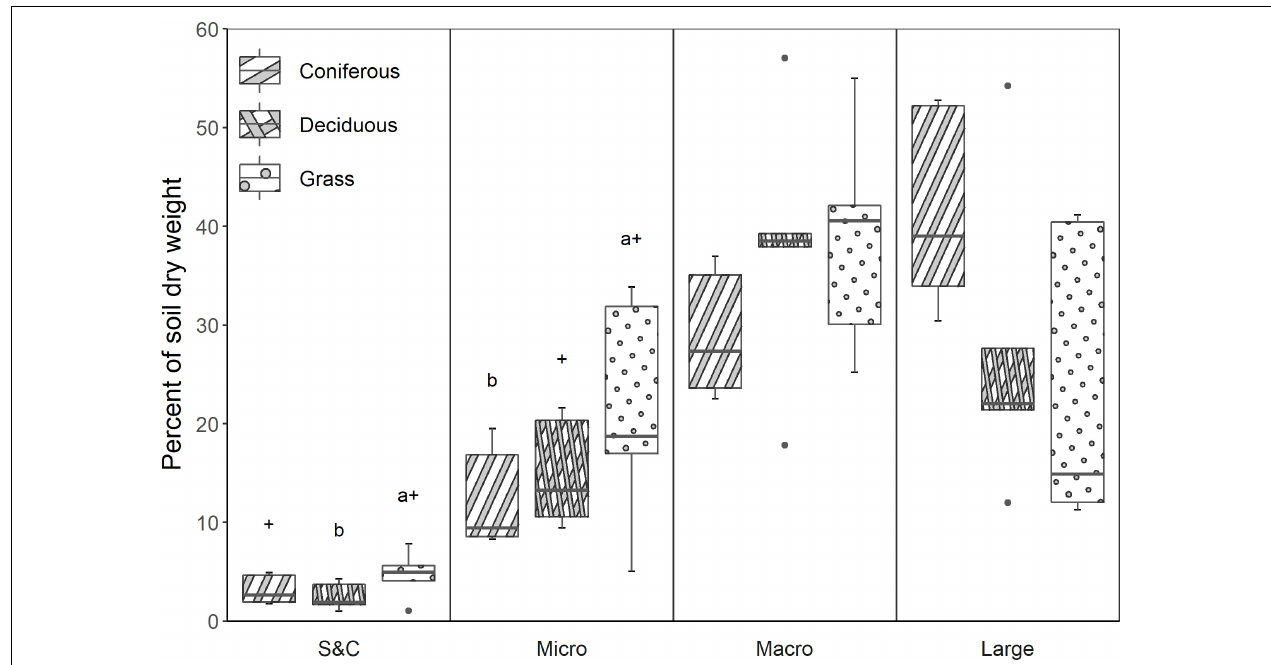
FIGURE 1 | Distribution of aggregate size classes (g aggregate g − 1 dry soil) among the three vegetation treatments, as a percentage of the total soil dry weight (S&C = silt-and-clay-sized fraction; Micro = microaggregates; Macro = macroaggregates; Large = large macroaggregates). Significant differences ( p ≤ 0.05) among treatments are noted using a letter above the boxplot, and differences in which p ≤ 0.10 are symbolized using